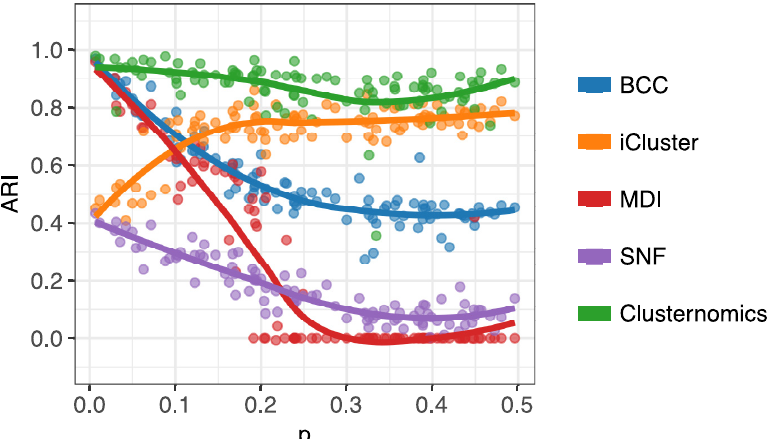
Fig 4. ARI comparing global clustering of simulated datasetswith misspecified number of clusters for varying values of p , when we set the number of global clusters to 5. Each point corresponds to a corresponding algorithmappliedto one dataset, the plot shows also the loess curve for each method. Higher values correspond to better agreement betweenthe estimated cluster assignmentsand the true cluster